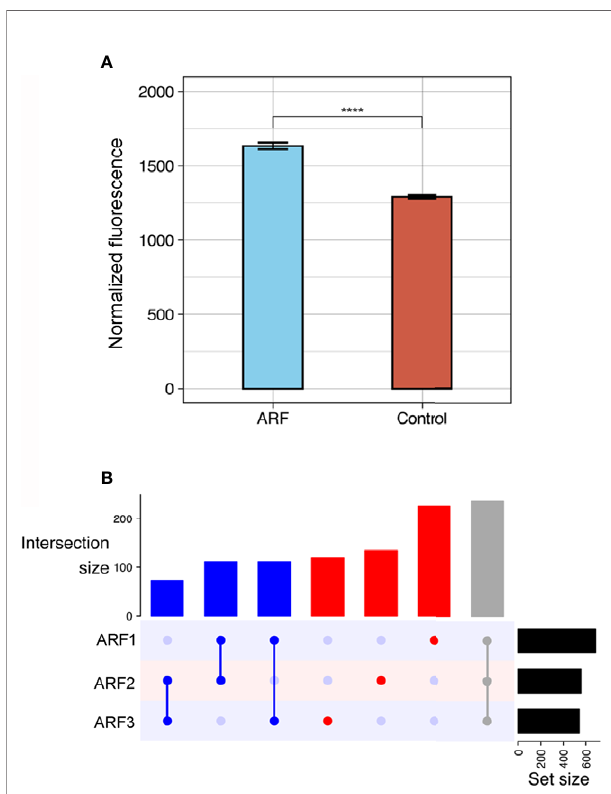
FIGURE 1 | Global autoantibodyanalysis in ARF using ProtoArrays. (A) Overall antibodybinding intensities against human proteins in ARF patients (blue, n=3) andgroupedcontrols (red, n=6). Controls comprise bothhealthy children(n=3) and children with GAS positive pharyngitis (n=3). Bars indicate mean and standard error. ****p < 0.0001 using two sampleWilcoxon test. (B) Upset plot showing number of shared autoantibodies betweenARF patients (ARF1, 2 and 3). Autoantibodies shared between allthree ARF patients are indicated in grey, those sharedbetweenat least two patients in blue andthose unique to anindividual patient in red. The number ofautoantibodies in eachcategoryisindicated on vertical bar charts with respective colours. Upset plots include onlyantibodies that showedat least a two-fold enrichment when compared with the meanof grouped controls. Total number of auto-antibodies identi fi ed using this threshold per patient is indicated on horizontalbar charts (Set